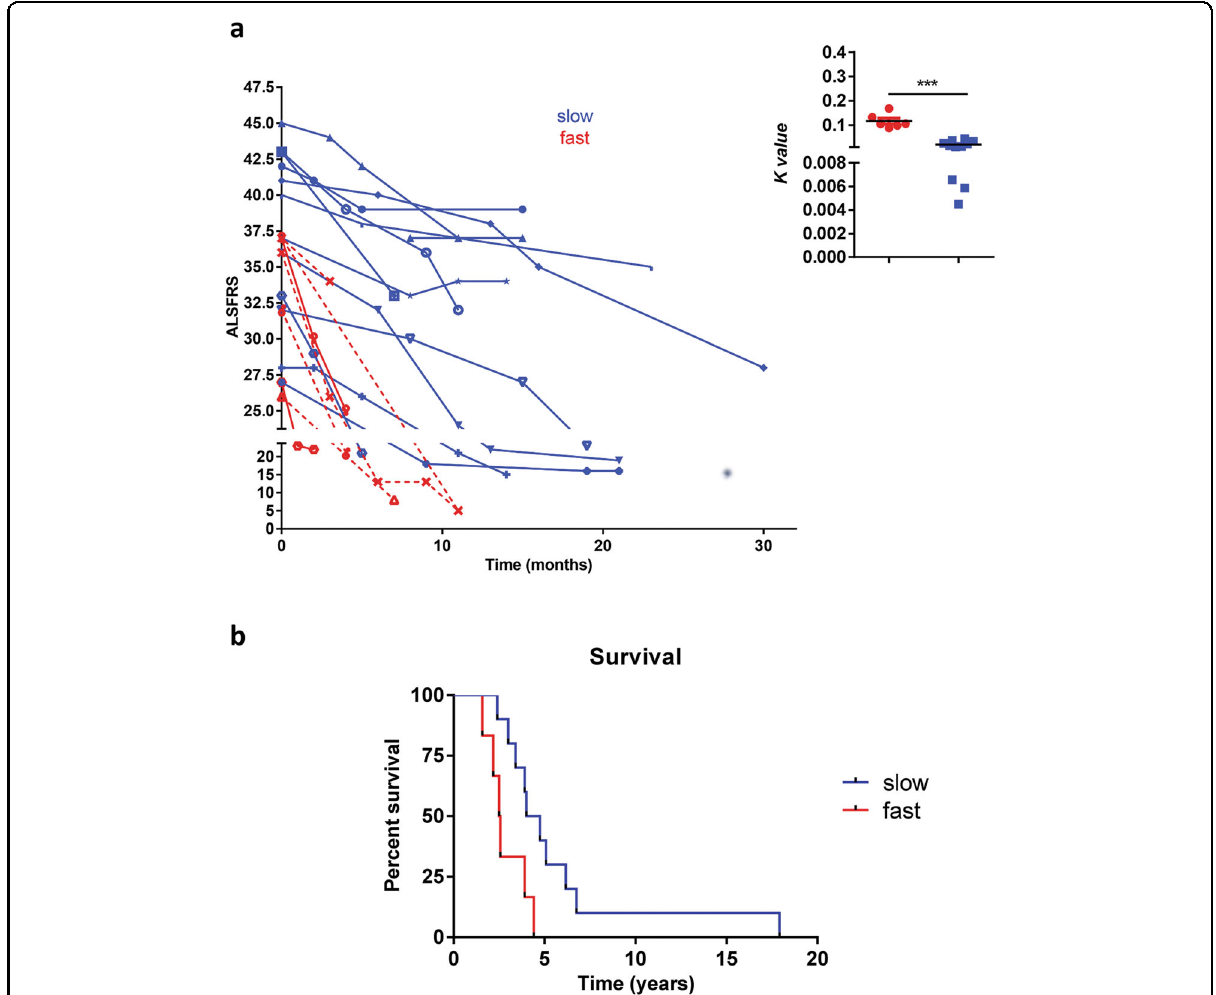
Fig. 2 ALS-FR score decline and patient survival during the whole study. a Exponential regression model for the ALS-FRS score during the study. Inset: K value decline parameters of fast progressive patients were signi fi cantly higher than slow progressive patients (Mann – Whitney test *** p = 0,0002). Lifelong duration b was signi fi cantly different in slow and fast progressive patients (Log-rank Mantel – Cox test p = 0.0256) N = 11 (slow), N = 6